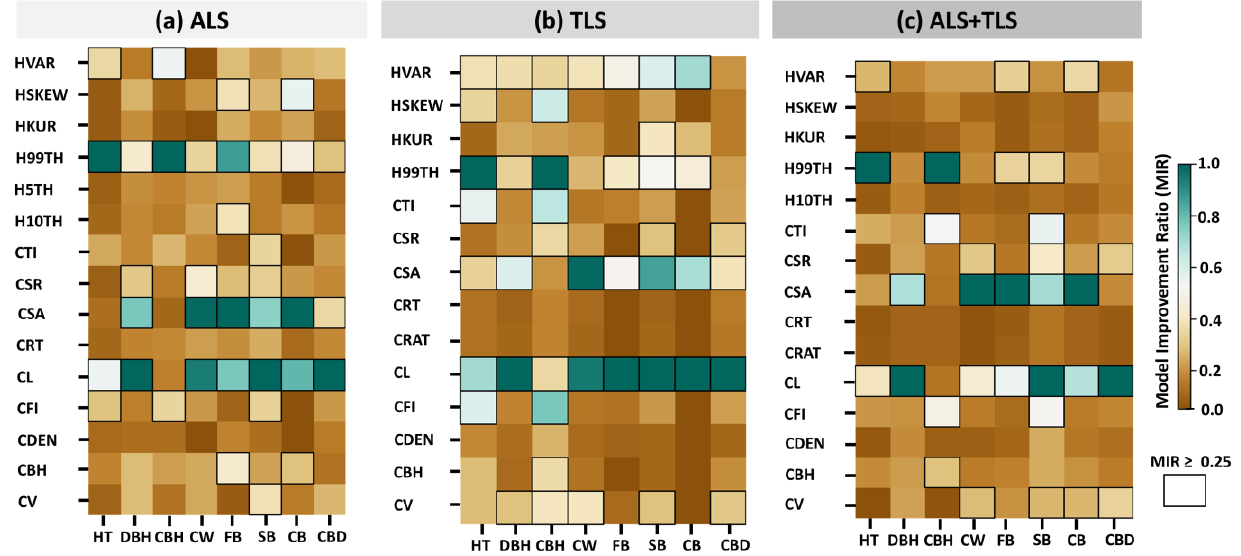
Figure 6. Mean model improvement ratio (MIR) of preselected metrics (i.e., metrics with Pearson’s correlation between − 0 .9 and 0.9 with each other). Metrics with MIR ≥ 0.25 were selected for modeling.